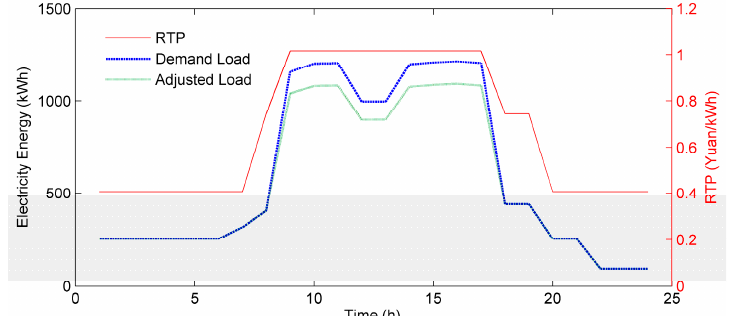
Figure 8. Strategies of NE in Scenario 2.